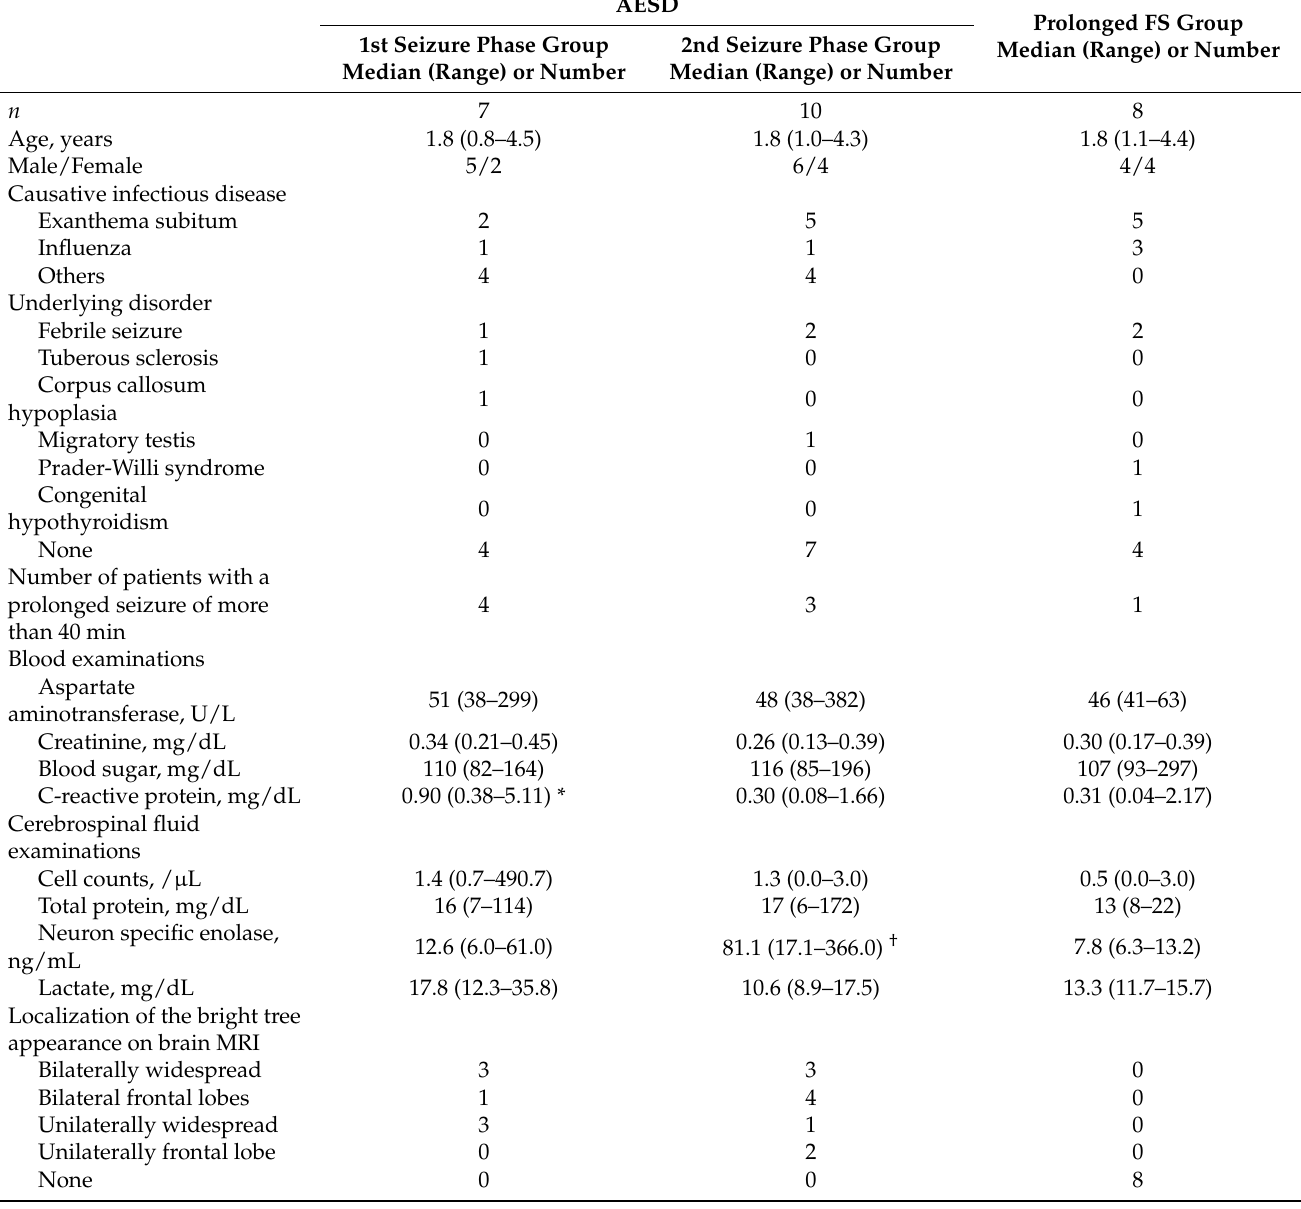
Table 1. Clinical and laboratory findings of patients with acute encephalopathy with biphasic seizures and late reduced diffusion (AESD) or prolonged febrile seizure